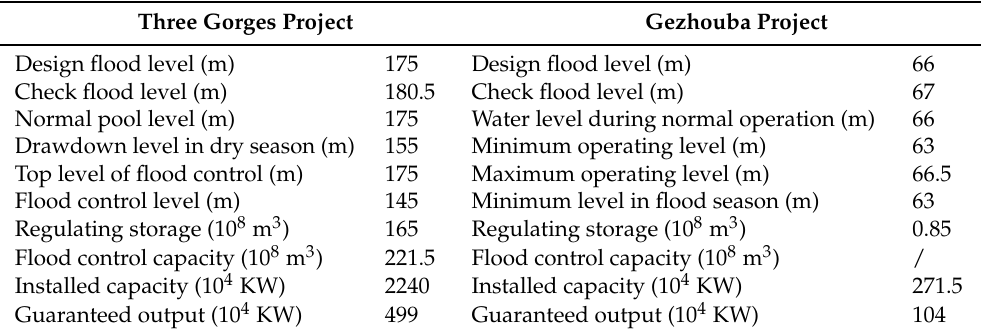
Table 1. Basic parameters of TG-GZB cascade